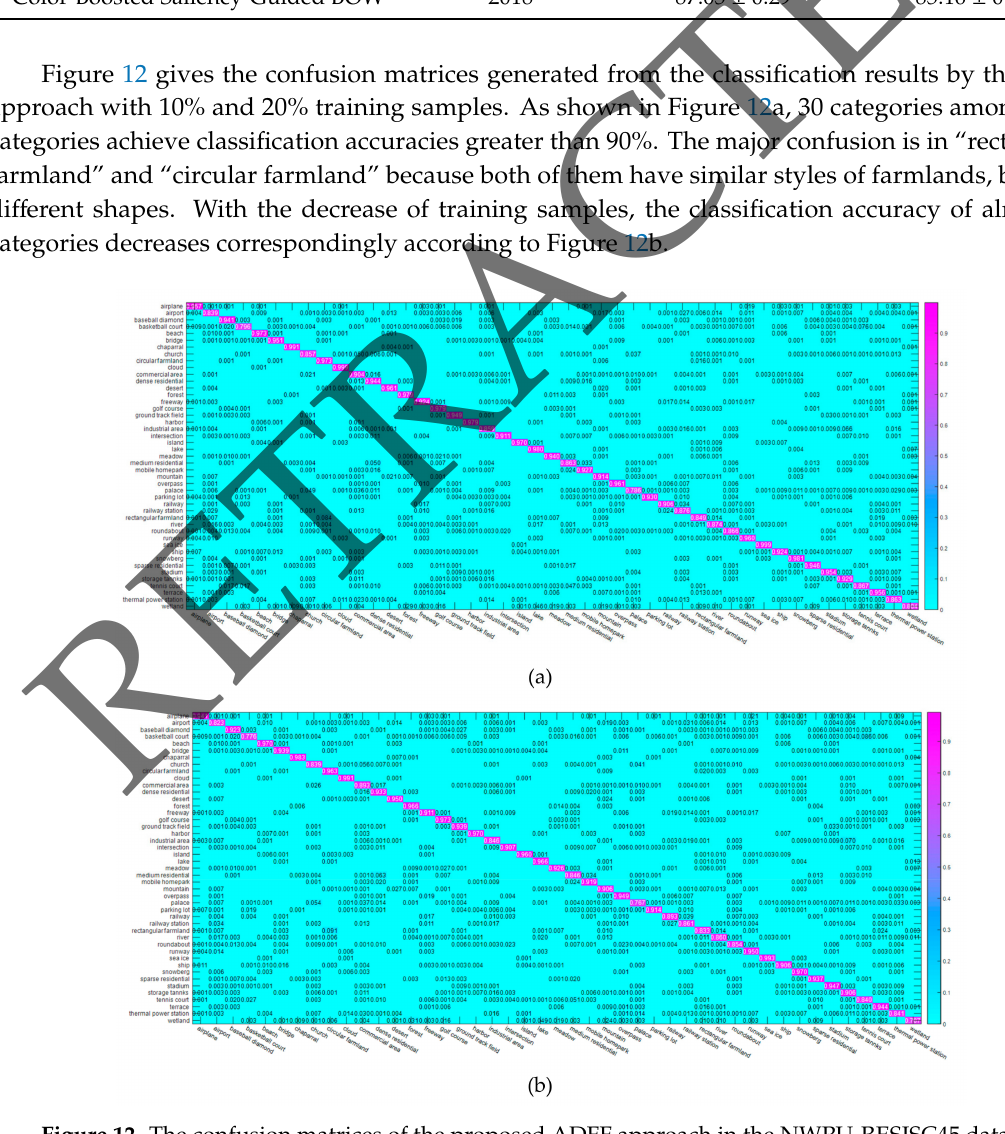
Figure 12. The confusion matrices of the proposed ADFF approach in the NWPU-RESISC45 dataset; ( a ) 20% training ratio, ( b ) 10% training